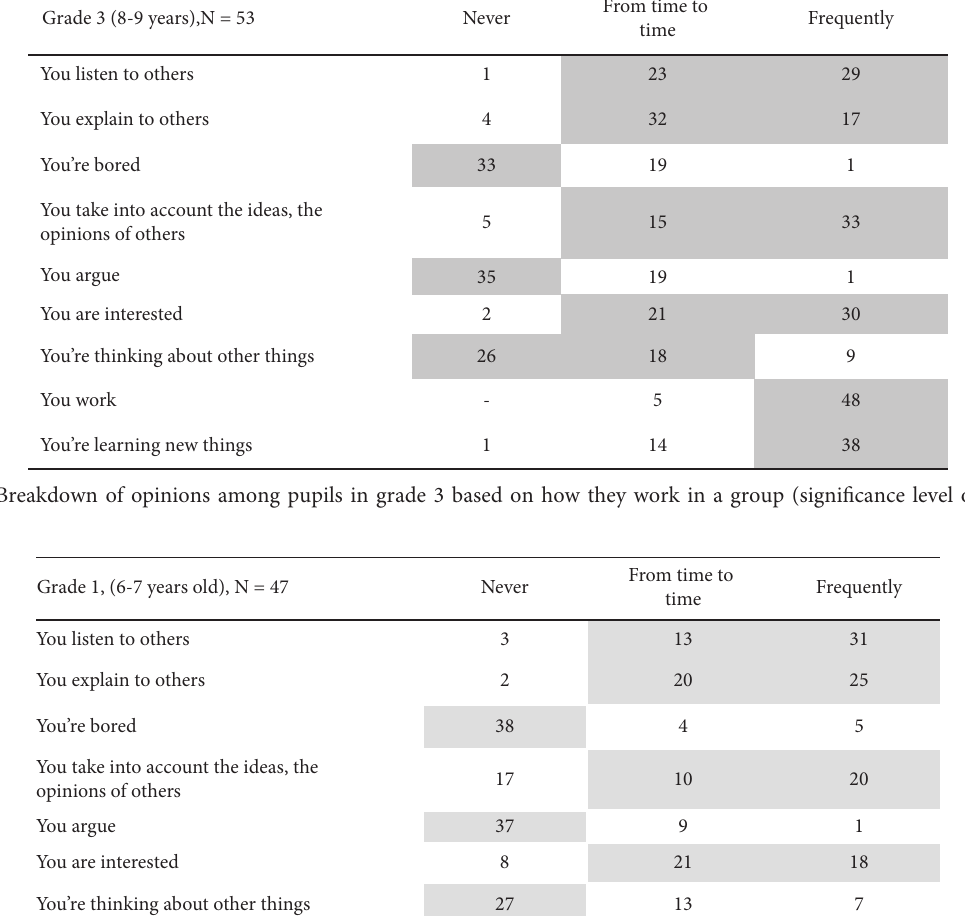
Grade 3 (8-9 years),N = 53